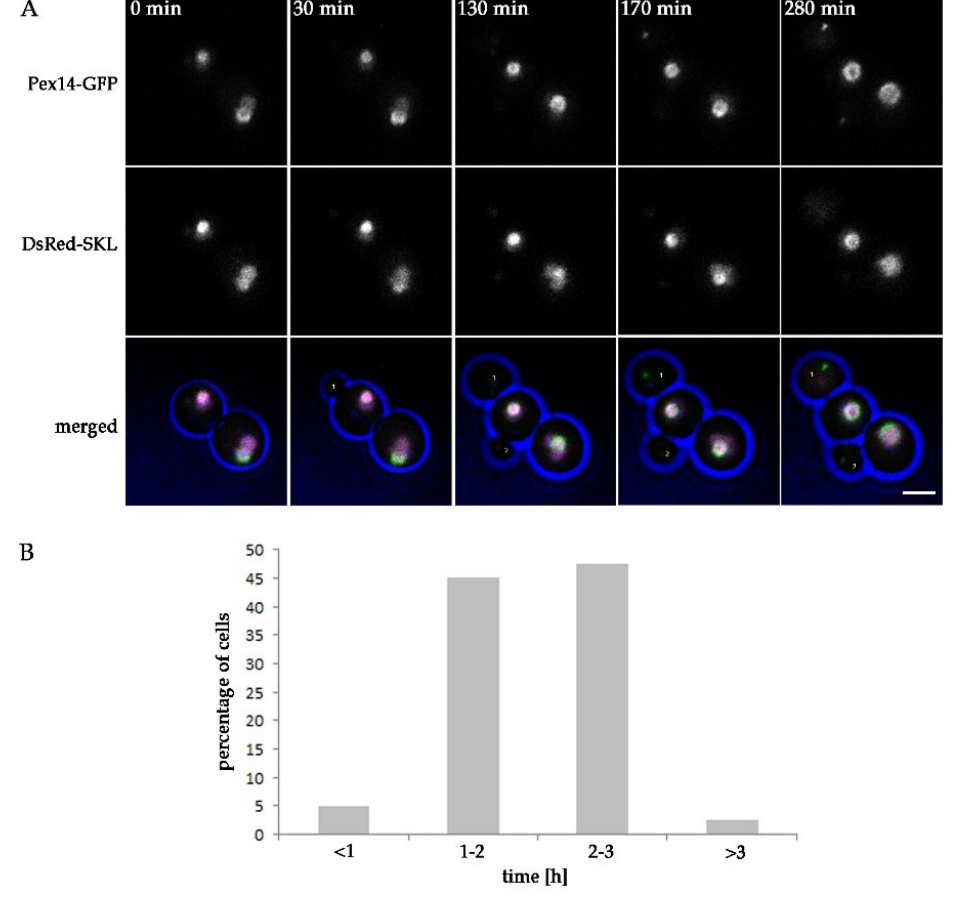
Figure 5. Peroxisomes re-appear in buds of the H. polymorpha pex11 inp2 strain. ( A ) Stills from a CLSM video (Supplementary Data S2) representing budding pex11 inp2 cells producing Pex14-GFP and DsRed-SKL. Blue represents cell edges. Numbers mark daughter cells that did not receive a Pex14-GFP spot from the mother cell and acquired it at later stages of growth. Scale bar represents 2 µ m. ( B ) Time between bud formation initiation and appearance of a Pex14-GFP spot in the pex11 inp2 buds. Initiation of bud formation was taken as a zero-time point, individually for each budding event. Forty cell budding events were included in the